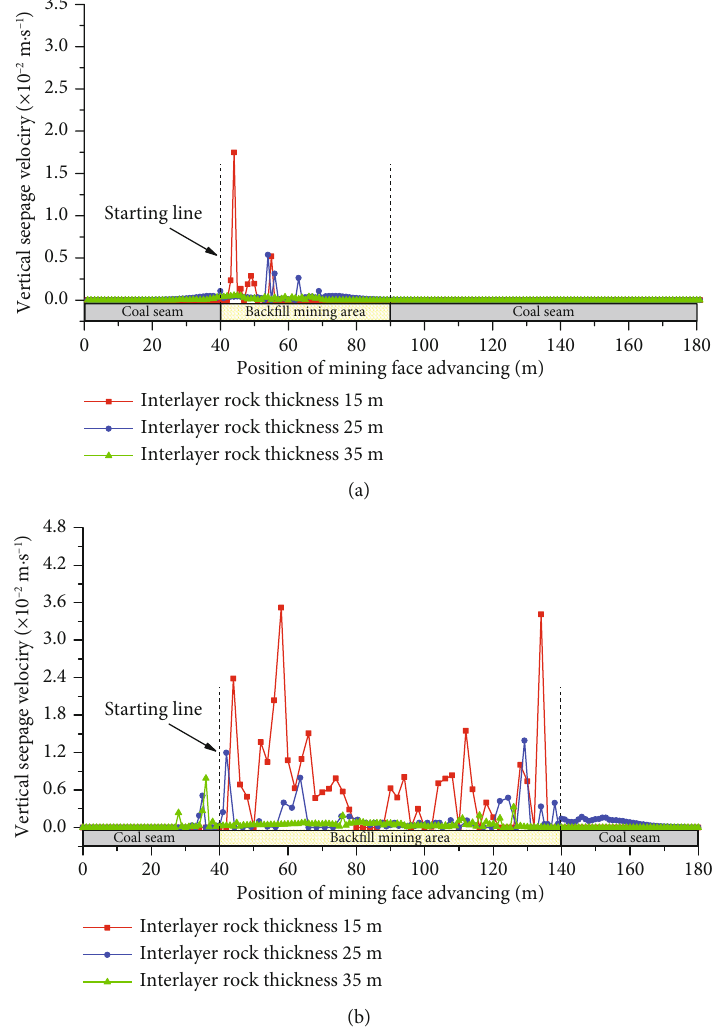
Figure 6: Vertical seepage fl ow distribution of KAS with di ff erent interlayer rock thickness: (a) advancing distance 50m; (b) advancing distance